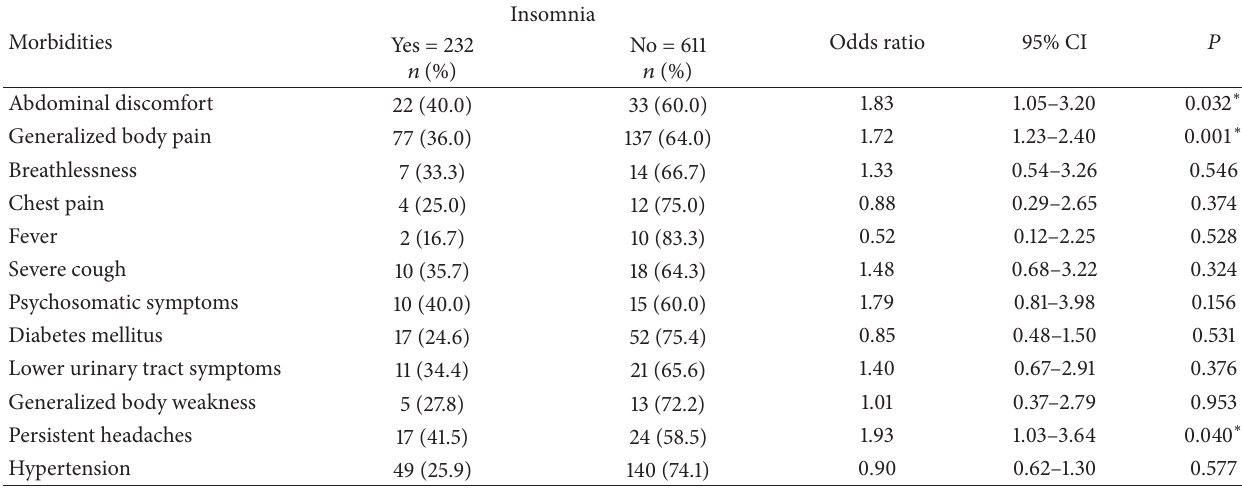
Table 4: Morbidities by prevalence of insomnia.